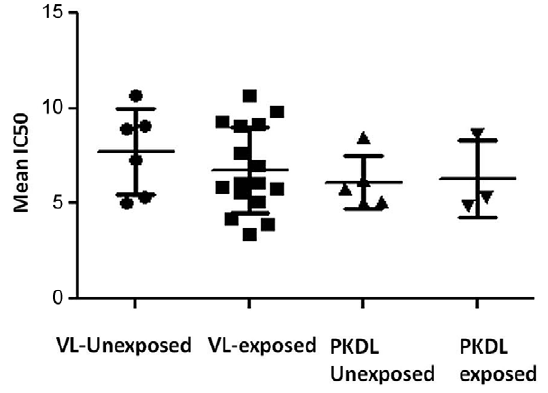
Figure 2. PMM susceptibility profile of VL and PKDL isolates exposed or non-exposed to MIL treatment. Susceptibility of VL and PKDL isolates at intracellular amastigote stage was determined by infection in murine macrophage cell line J774A.1. Each individual value represents mean IC 50 6 SD of the results from two separate assays.